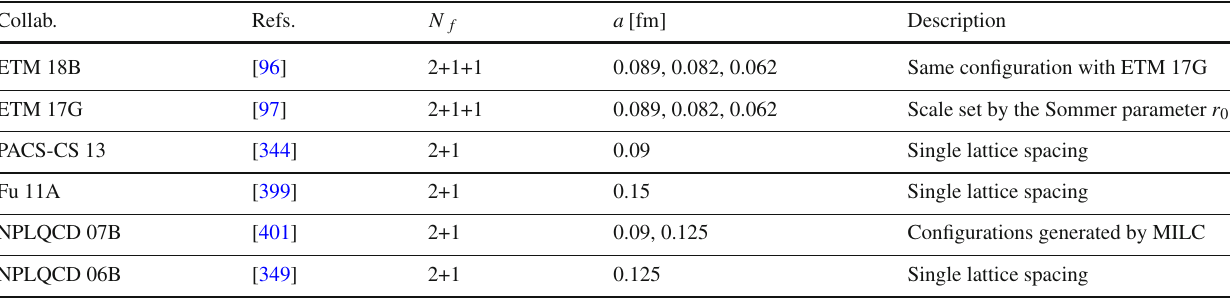
Table 112 Continuum extrapolations/estimation of lattice artifacts in determinations of the low-energy constants related to π K scattering Collab.